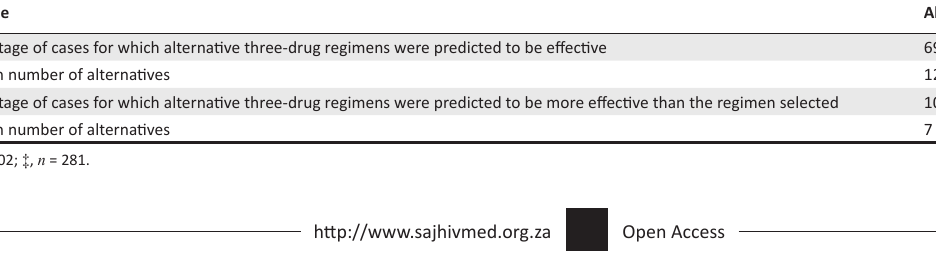
TABLE 3: In silico modelling to identify potentially effective alternative regimens for the Phidisa cases.